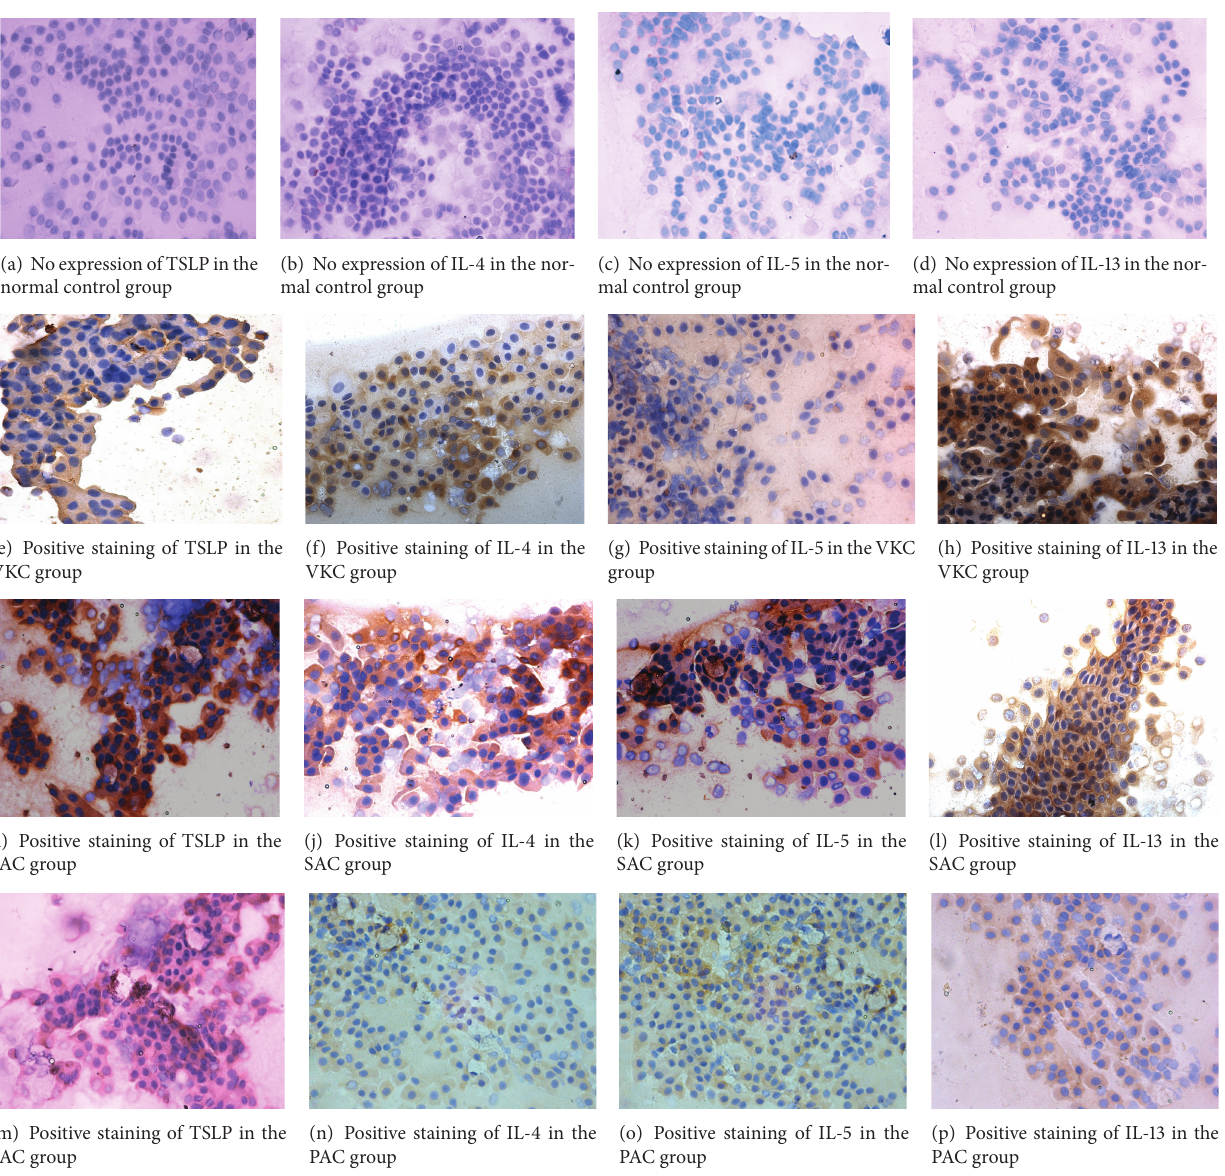
Figure 1: Detection of TSLP, IL-4, IL-5, and IL-13 protein expression by immunohistochemistry ( × 400). ((a), (b), (c), (d)) No expression of TSLP, IL-4, IL-5, and IL-13 in the normal control group. ((e), (f), (g), (h)) Positive staining of TSLP, IL-4, IL-5, and IL-13 in the VKC group. ((i), (j), (k), (l)) Positive staining of TSLP, IL-4, IL-5, and IL-13 in the SAC group. ((m), (n), (o), (p)) Positive staining of TSLP, IL-4, IL-5, and IL-13 in the PAC group. Brown granules showed positive